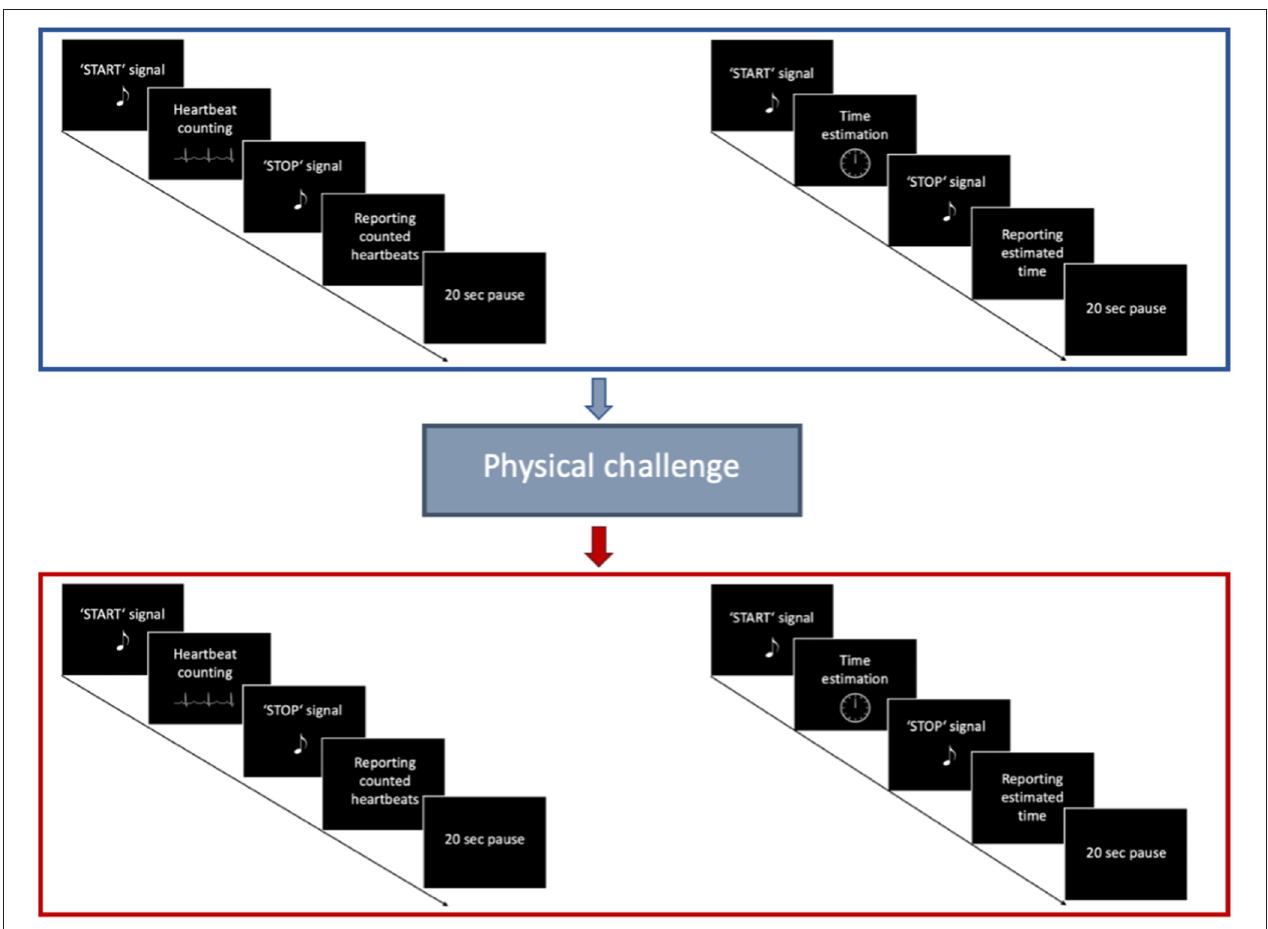
FIGURE 2 | Trial structure of the Heartbeat tracking task. First, participants performed the HBT for five different time intervals in a pseudorandomized order. Afterwards, they performed a Time estimation task for the same time intervals. After a short physical challenge of 10 squats was implemented, participants performed once again the HBT, followed by the Time estimation